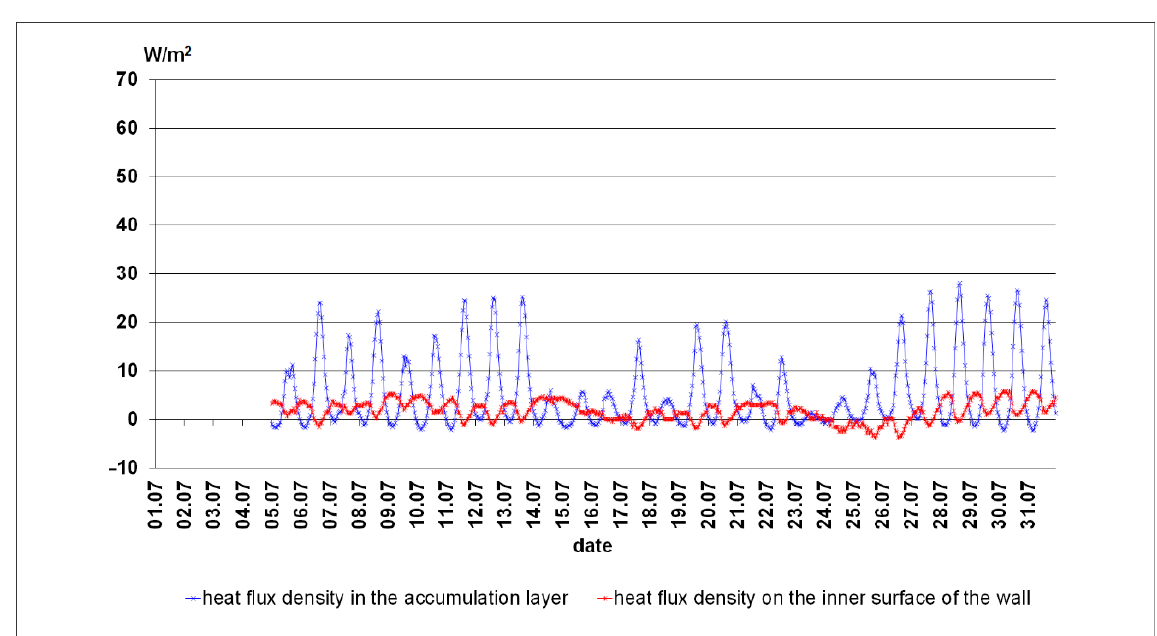
Figure 14. Graph of heat flux density flowing through the storage layer and on the inner surface of the wall in July. In June, the average value of the inner surface temperature of the wall was 28.60 ◦